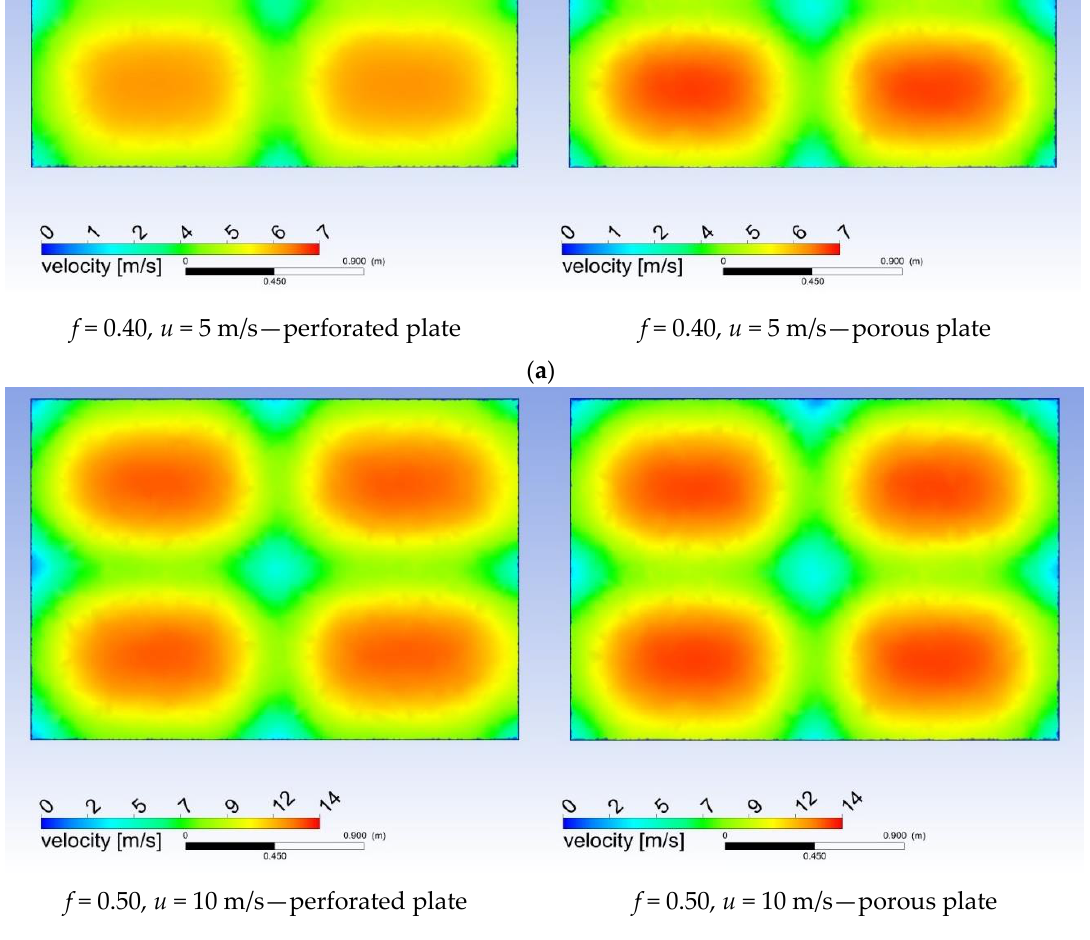
Figure 15. Velocity module field at distance of 100 cm behind the plates, f = 0.50, for inlet velocities 5 m/s and 10 m/s. ( a ) Velocity field for the perforated plate with open area ratio f = 0.40 (left) and corresponding porous core (right), velocity inlet u = 5 m/s. ( b ) Velocity field for the perforated plate with open area ratio f = 0.50 (left) and corresponding porous core (right), velocity inlet u = 10